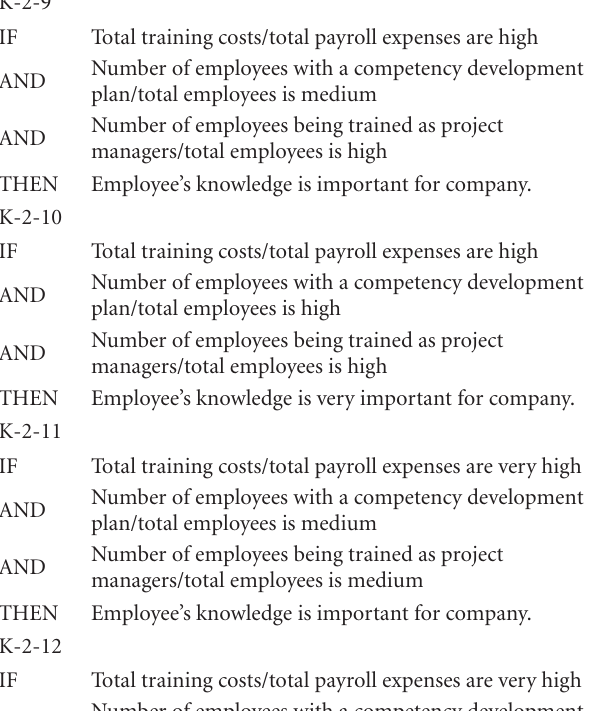
Table 2: Fuzzy rule set for employee’s knowledge